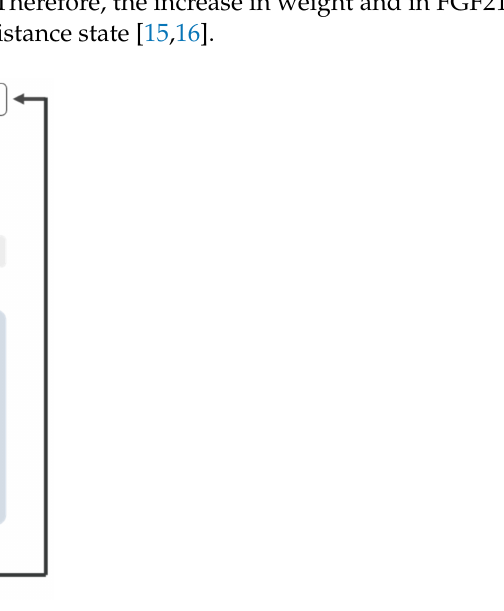
Figure 1. Infographic of the circulus vitiosus of obesity. Detailed information is provided in the